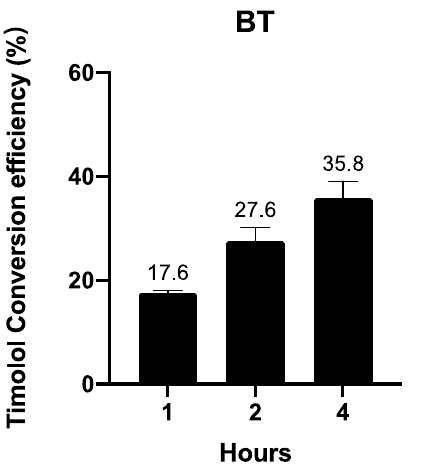
Figure 5. Ex vivo timolol conversion efficiency of 1 µ M BT in human skin. Data are presented as the mean ± SD (n = 3).